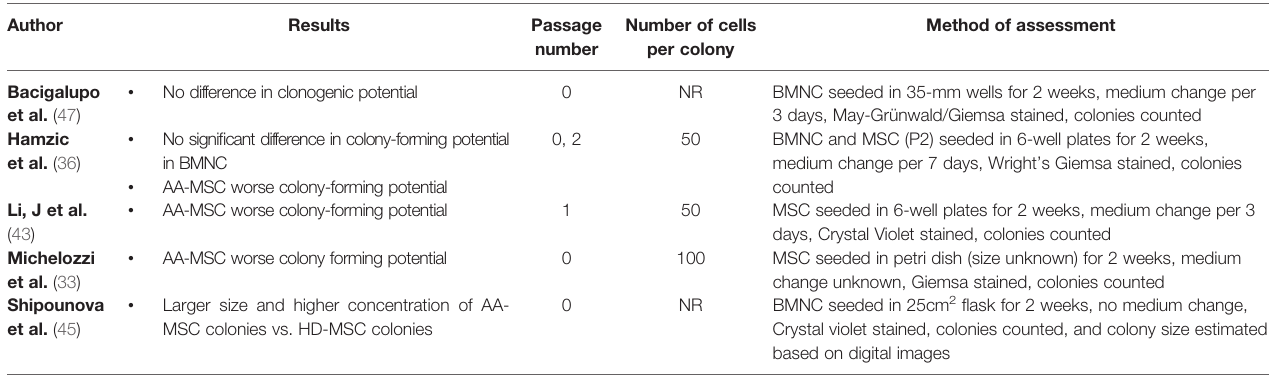
TABLE 6 | Colony forming unit- fi broblast ability